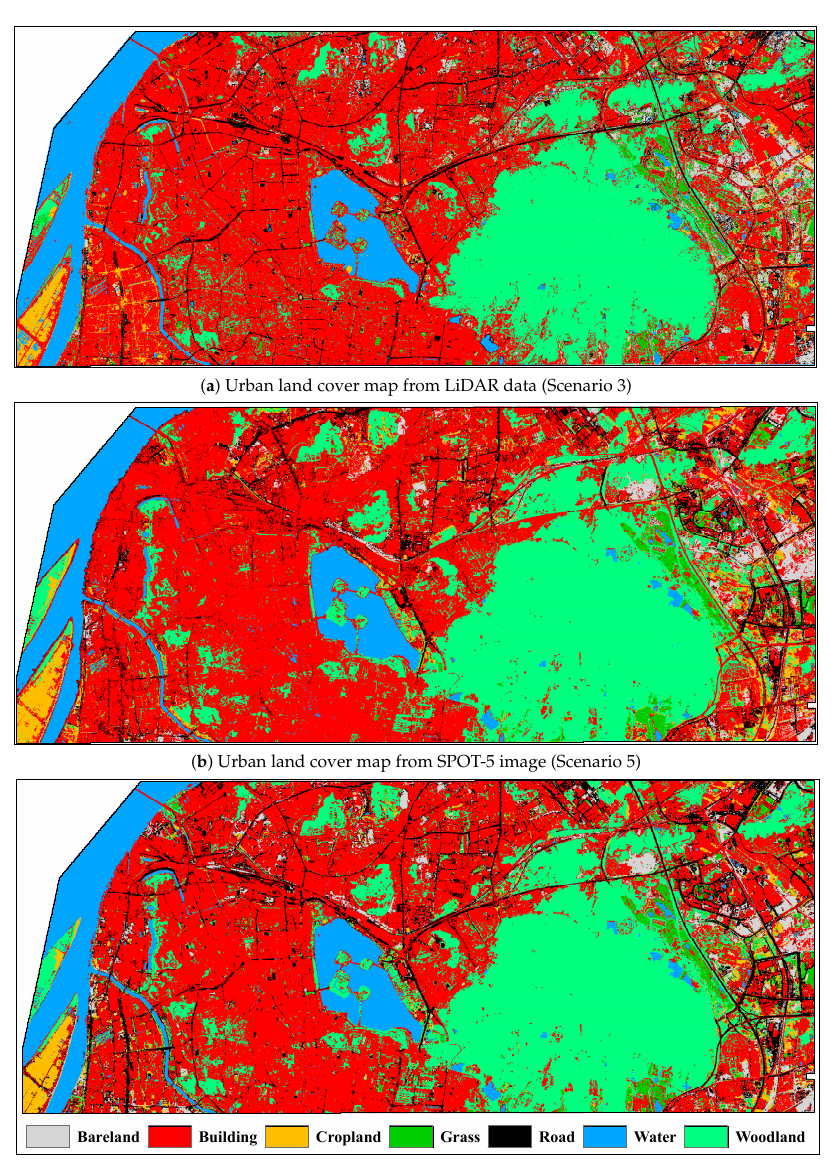
Figure 3. Classified urban land cover maps generated by Random Forests classifier with different input